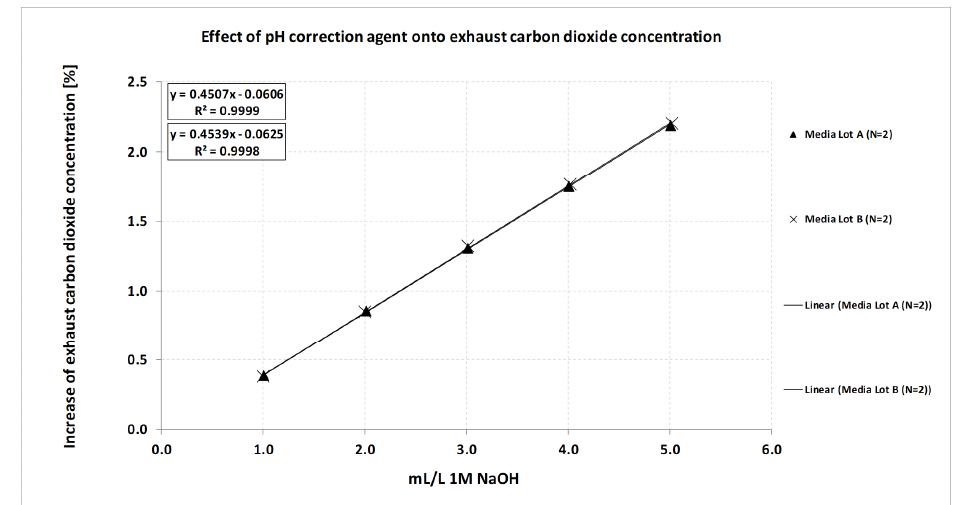
Figure 4. Effect of pH correction agent 1 M NaOH on the exhaust carbon dioxide concentration in 2 L bioreactor systems with active pH control and carbon dioxide gas as the acidic component. In the range